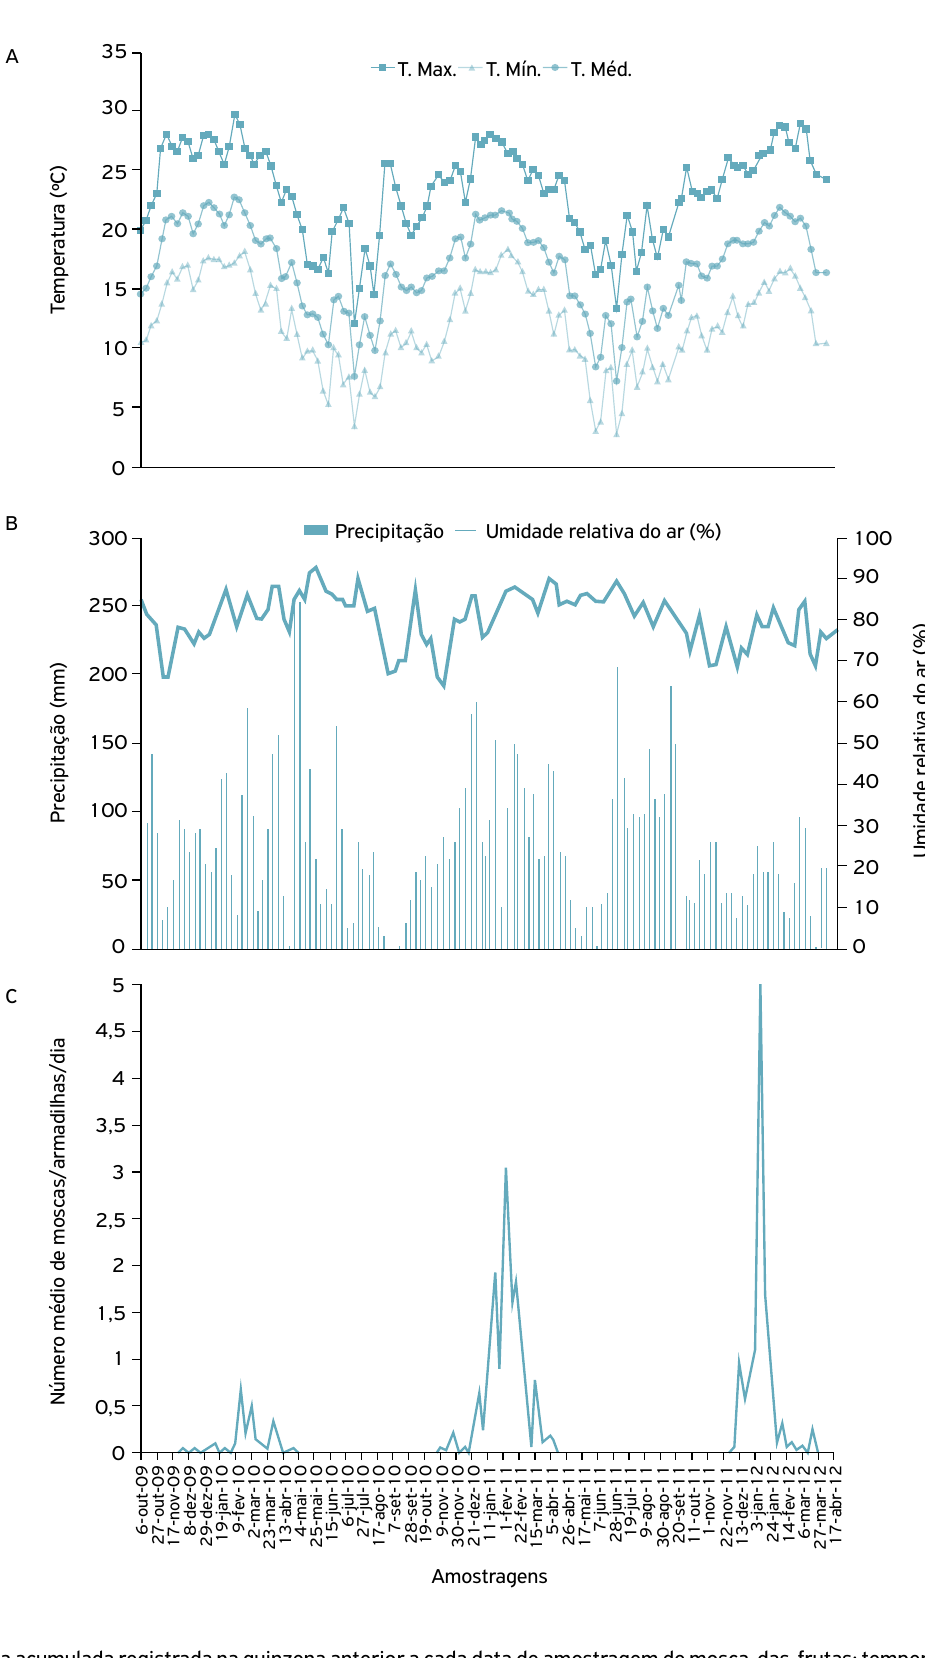
Figura 1. Média acumulada registrada na quinzena anterior a cada data de amostragem de mosca-das-frutas: temperaturas máxima, média e mínima (A); precipitação pluviométrica acumulada e umidade relativa do ar (B); e flutuação populacional de Anastrepha fraterculus (C) de outubro de 2009 a abril de 2012 (Caçador, Santa